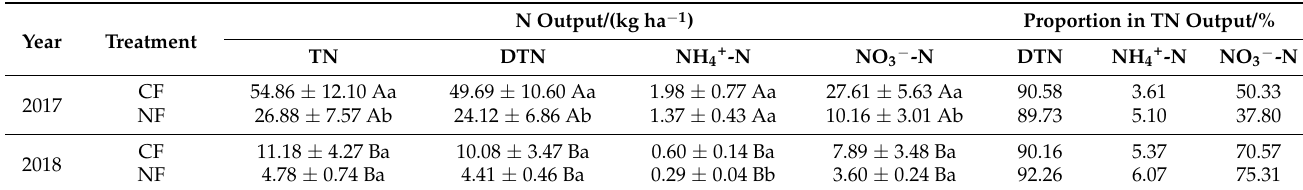
Table 2. Loss amount and rate of N via leakage in peanut-growing season.